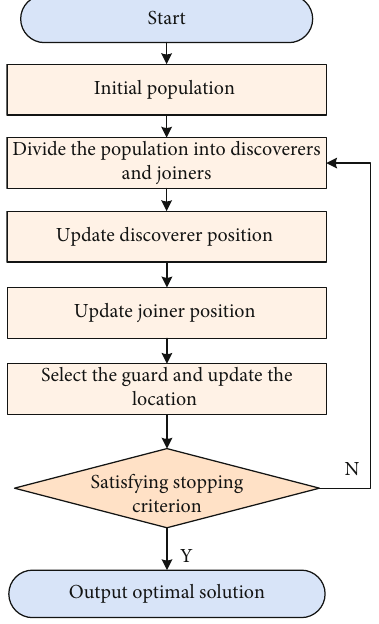
Figure 3: SSA algorithm fl ow